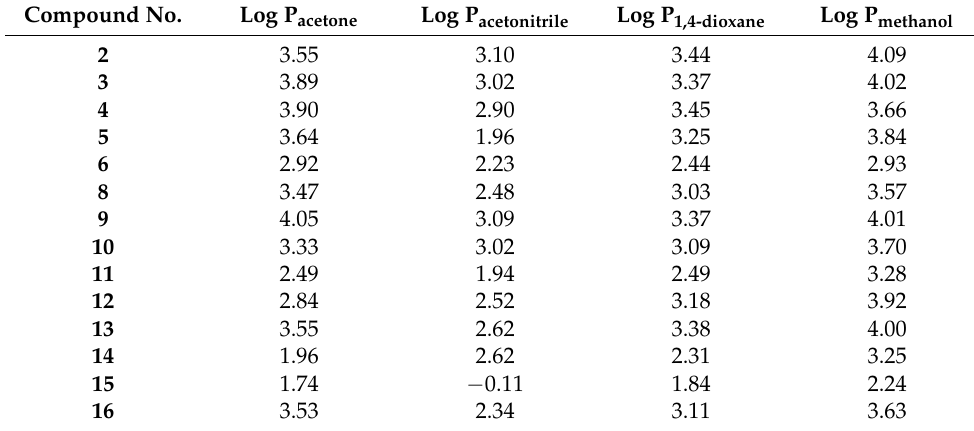
Table 3. The log P EXP values of the synthesized 4-methyl-1,2,3-thiadiazole-5-carbooxylic acid deriva- tives ( 2 – 6 and 8 – 16